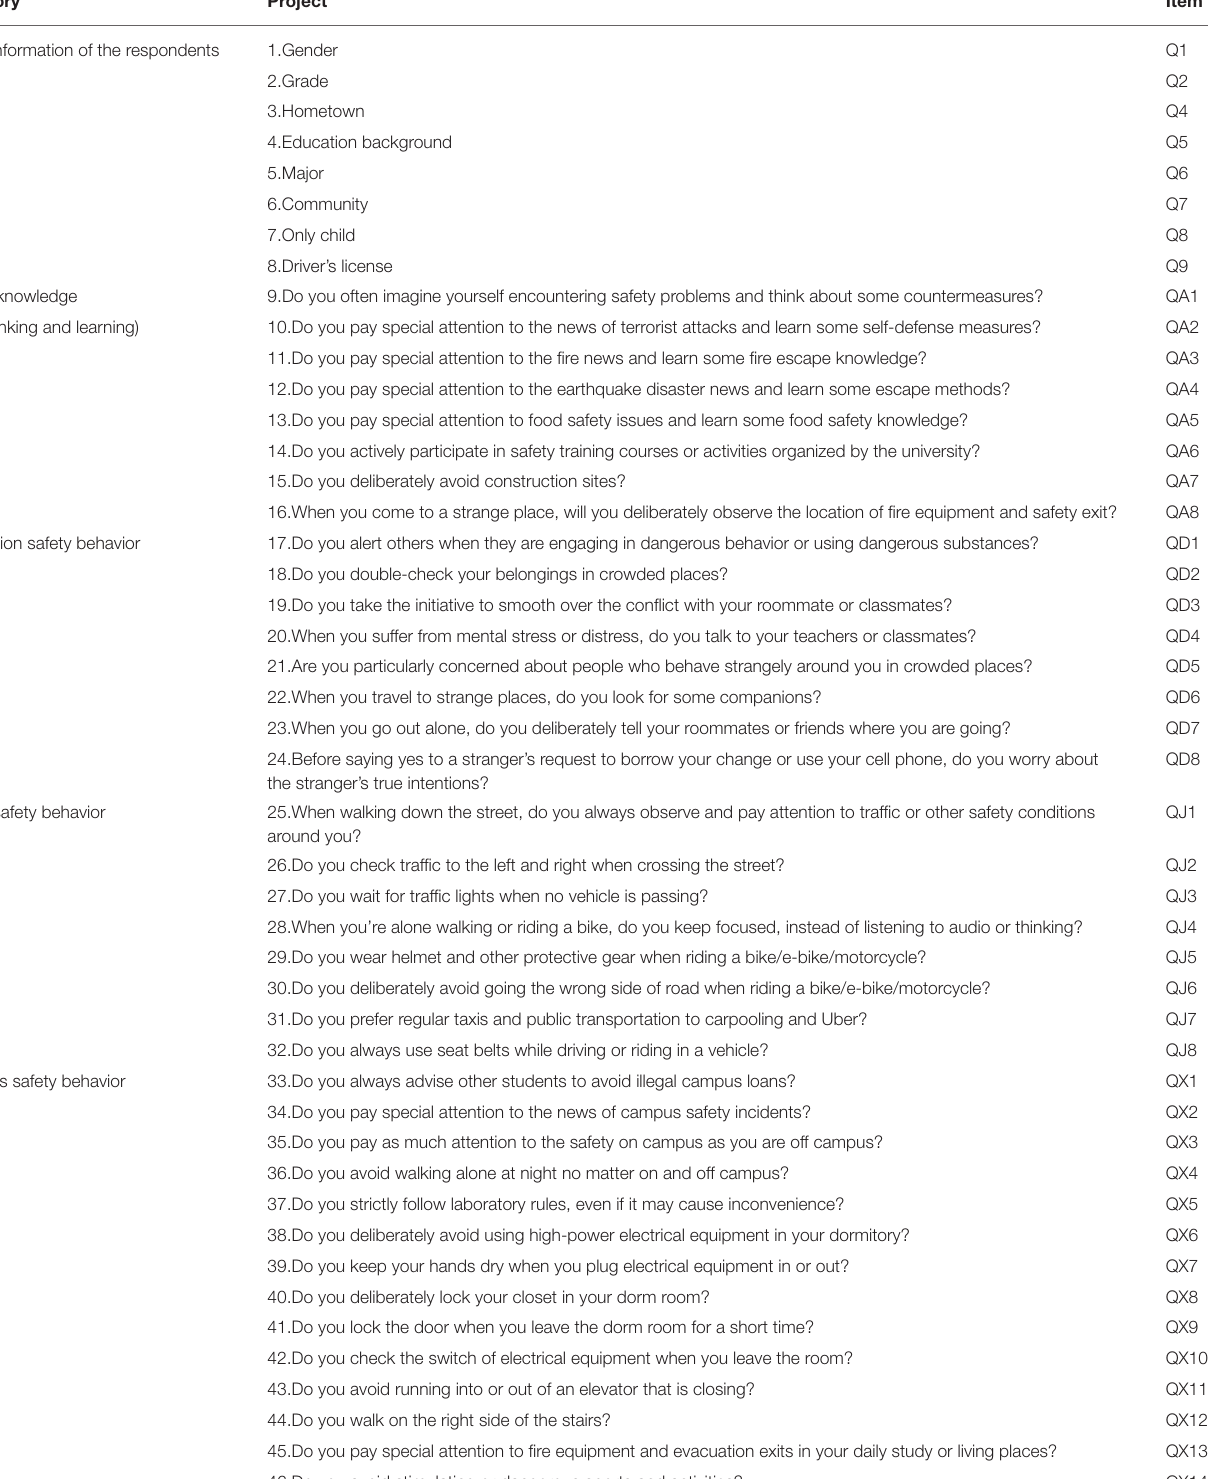
TABLE 1 | Safety culture items and basic information of undergraduates in a private university. Category Project Item Basic information of the